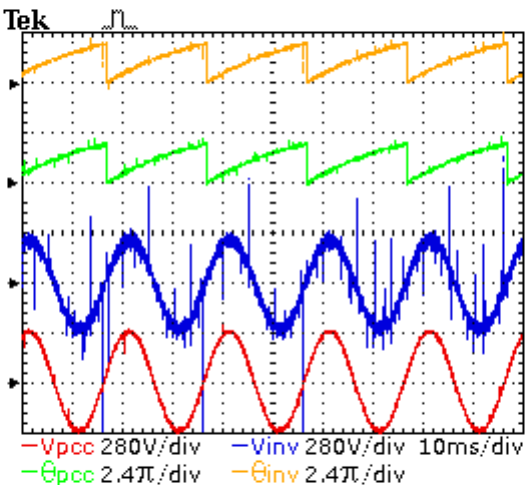
Figure 18. Output terminal voltage of grid-connected inverter and three-phase